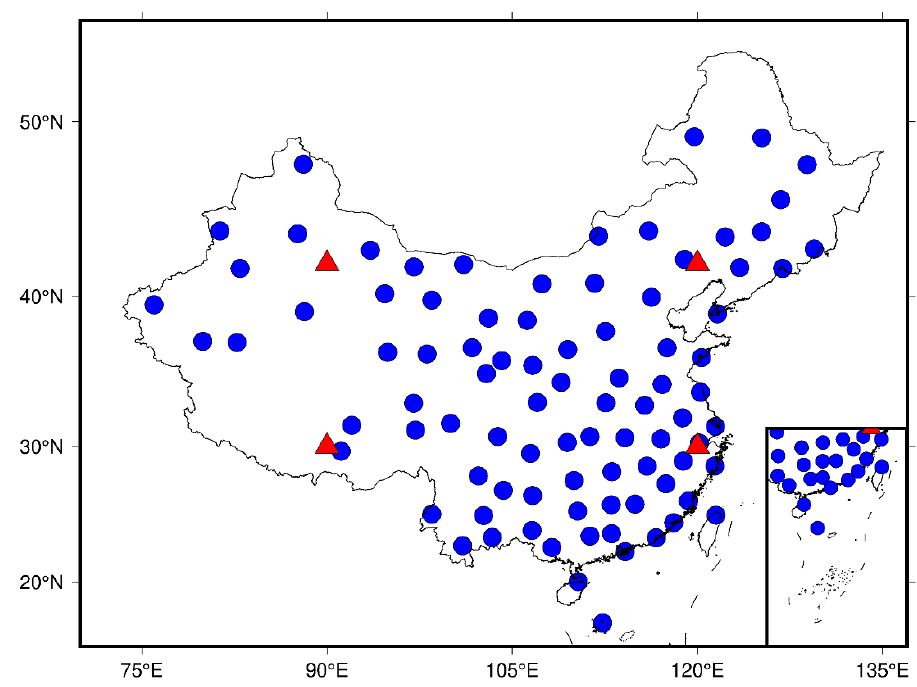
Figure 1. Distribution of 89 radiosonde stations over China. Blue dots are radiosonde stations, and red triangles are representative grid points.